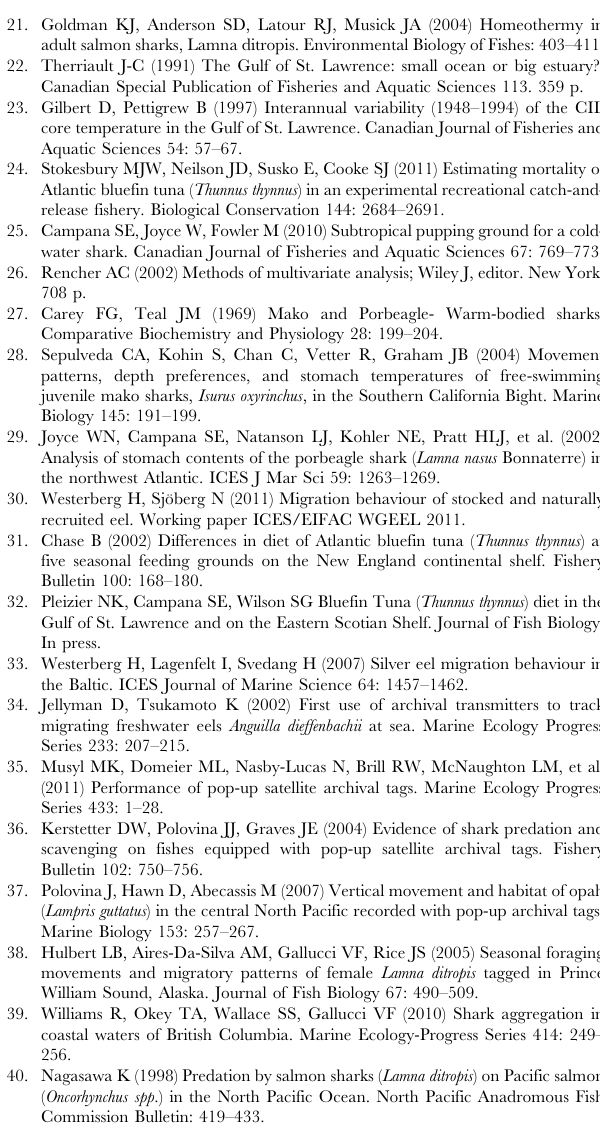
Table S1 Results of the statistical comparison between predator vertical profiles: Spearman rank correlation mean (Mean cc value) and maximum values (Max cc value), and proportion of non- significant values